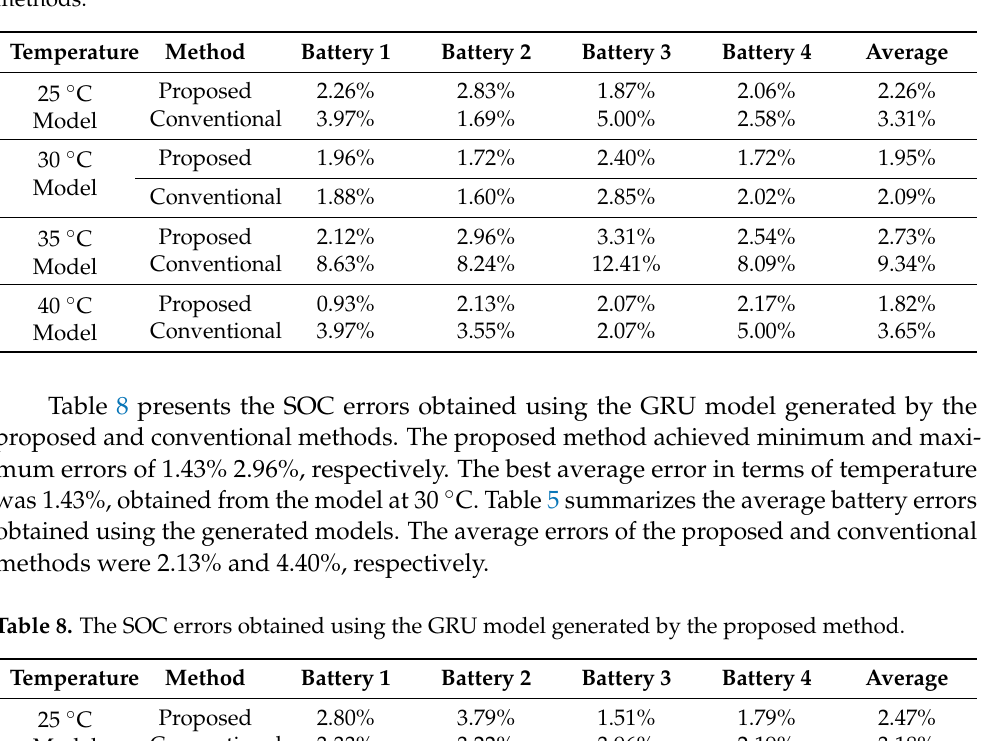
Table 7. The SOC errors obtained using the LSTM model generated by the proposed and conventional methods.